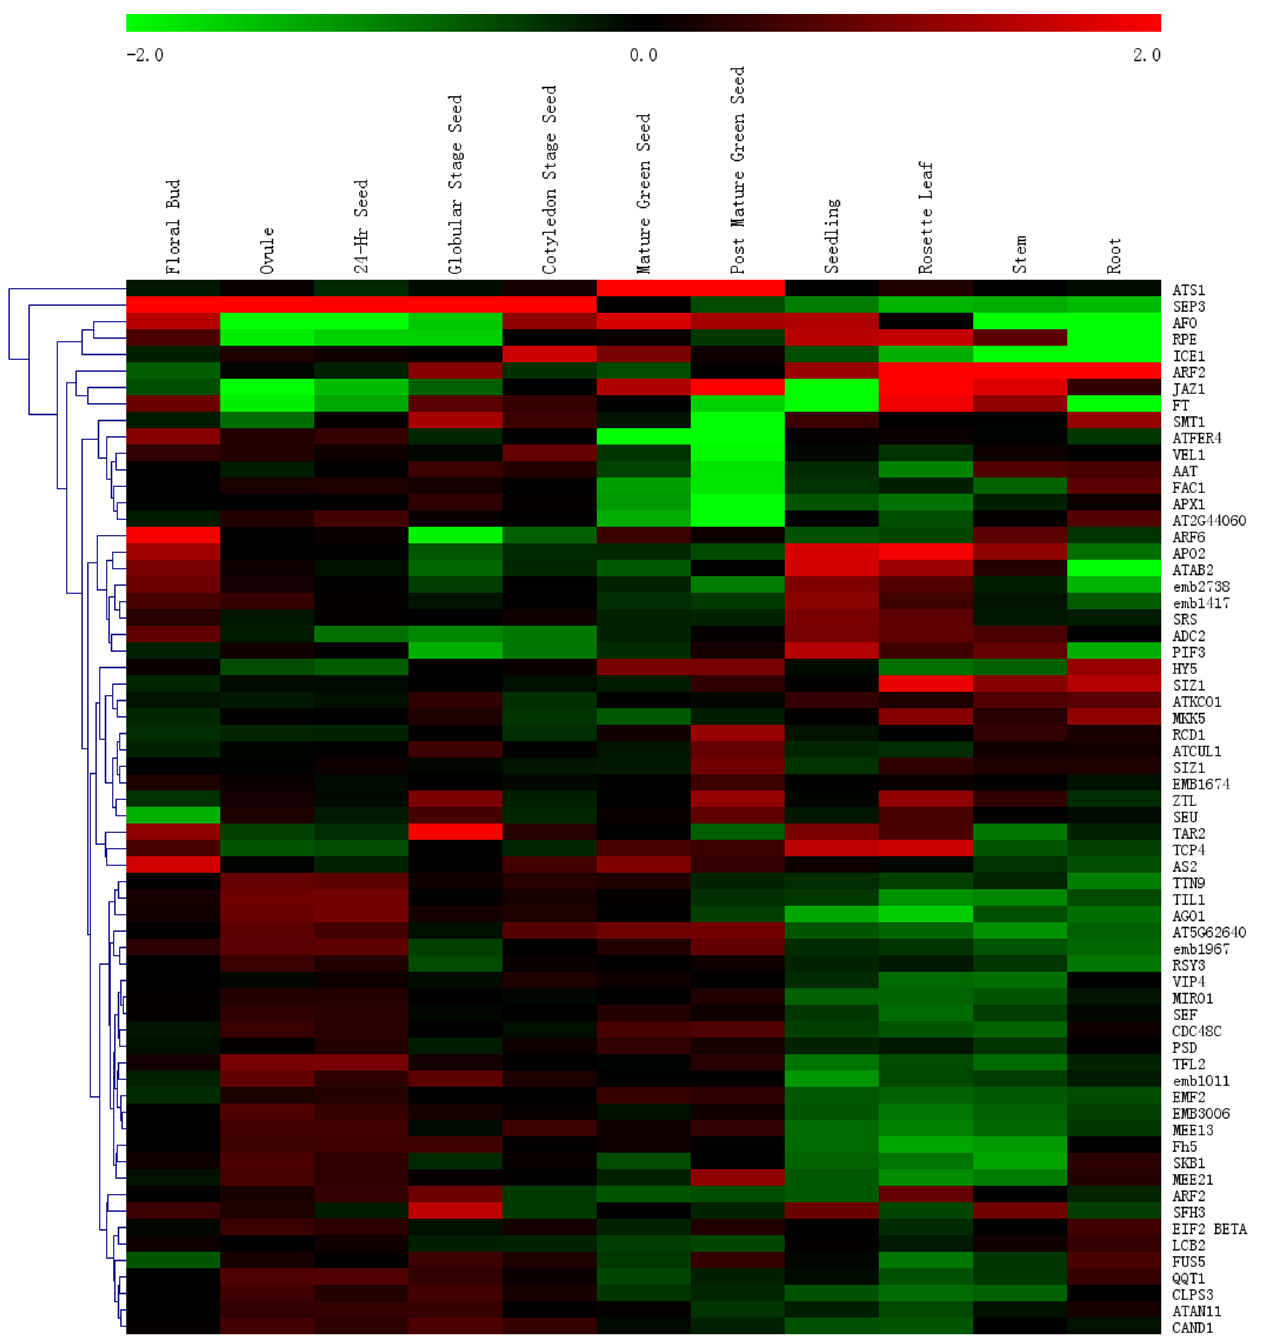
Fig 7. Expression profile of 64 Arabidopsis PEDG orthologs during seed development. Seventy R . soongorica -specific conserved PEDGs and 64 corresponding Arabidopsis genes exhibited specific probes on the microarray.